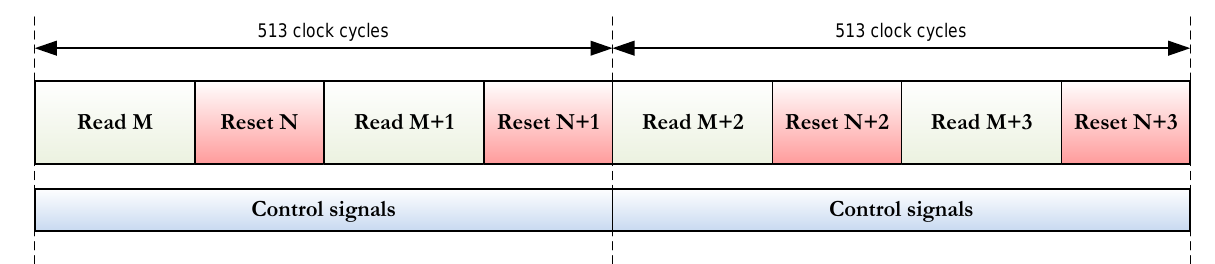
Figure 3. Relationship between decoder signal (image row address) and Control signals in STD mode. Red slot indicates the row to be reset and green slot indicates the row to be read.